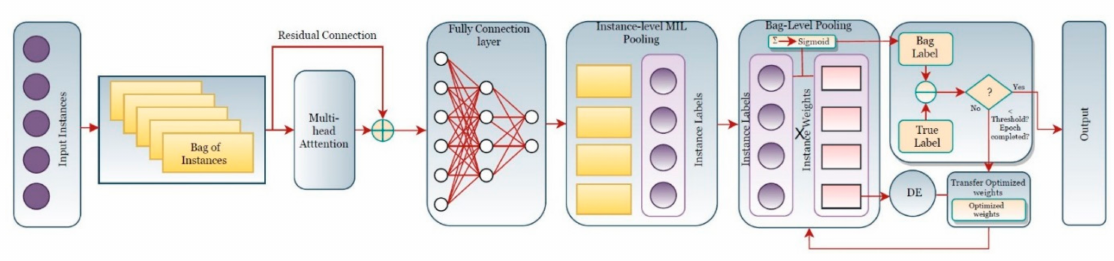
Figure 6. AMI-Net with DE